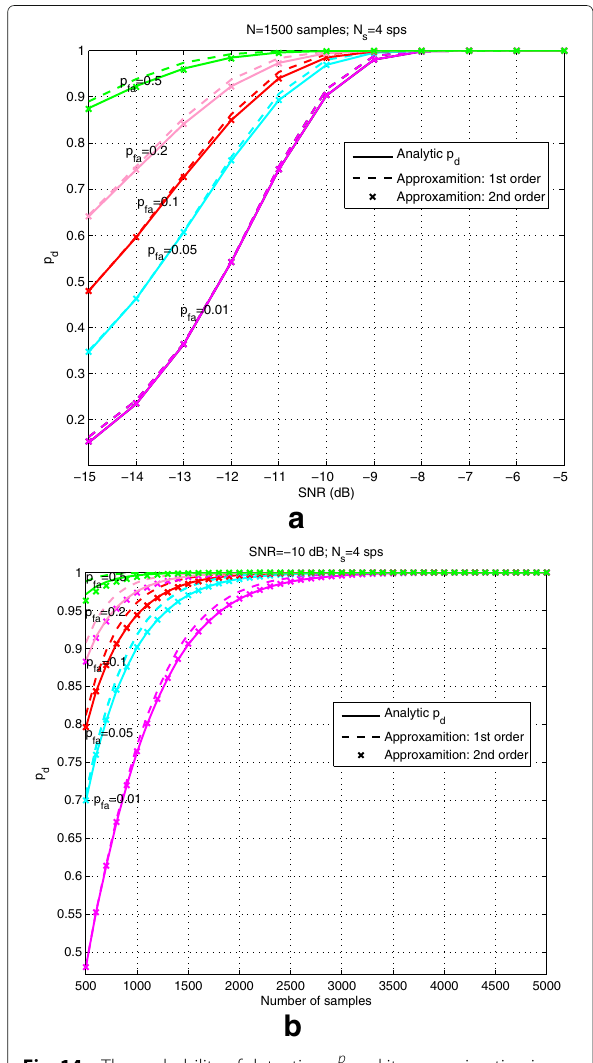
Fig. 14 a The probability of detection p p and its approximation in d terms of SNR for different p fa , N = 1500 samples and N s = 4 sps. b The probability of detection p p and its approximation in terms of the d number of samples N , for different p fa , SNR= − 10 dB samples, and N s = 4